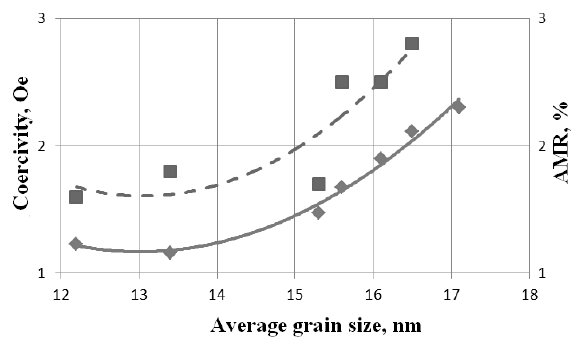
Fig. 4. The dependence of the coercivity (dashed line) and the AMR (solid line) on the average grain size.